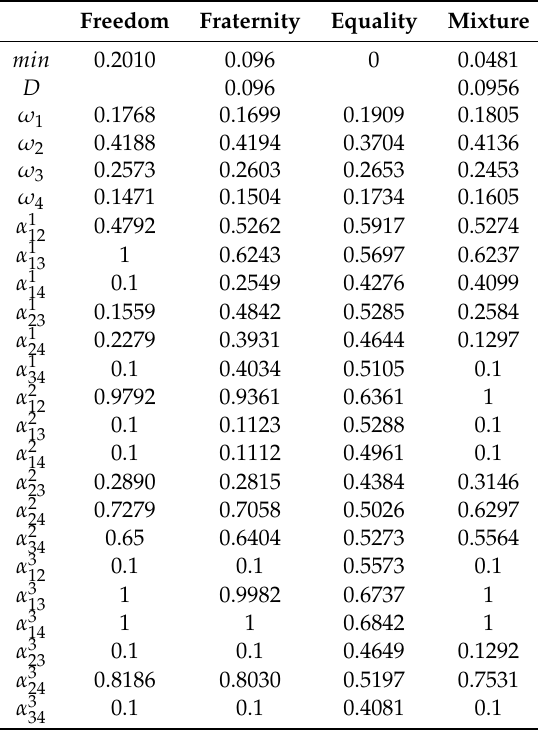
Table 1. Results of the model with I